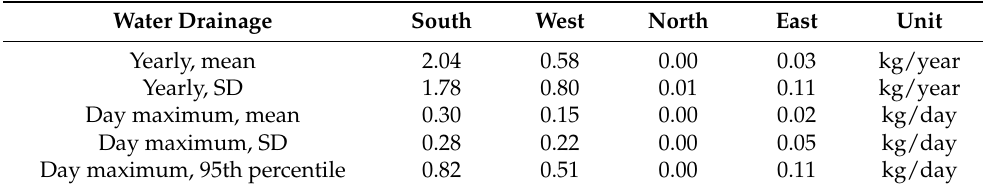
Table 9. Comparing yearly mean and yearly day maximum water drainage for four different directions of facade 2006–2095. Mean values, standard deviation and 95th percentile.